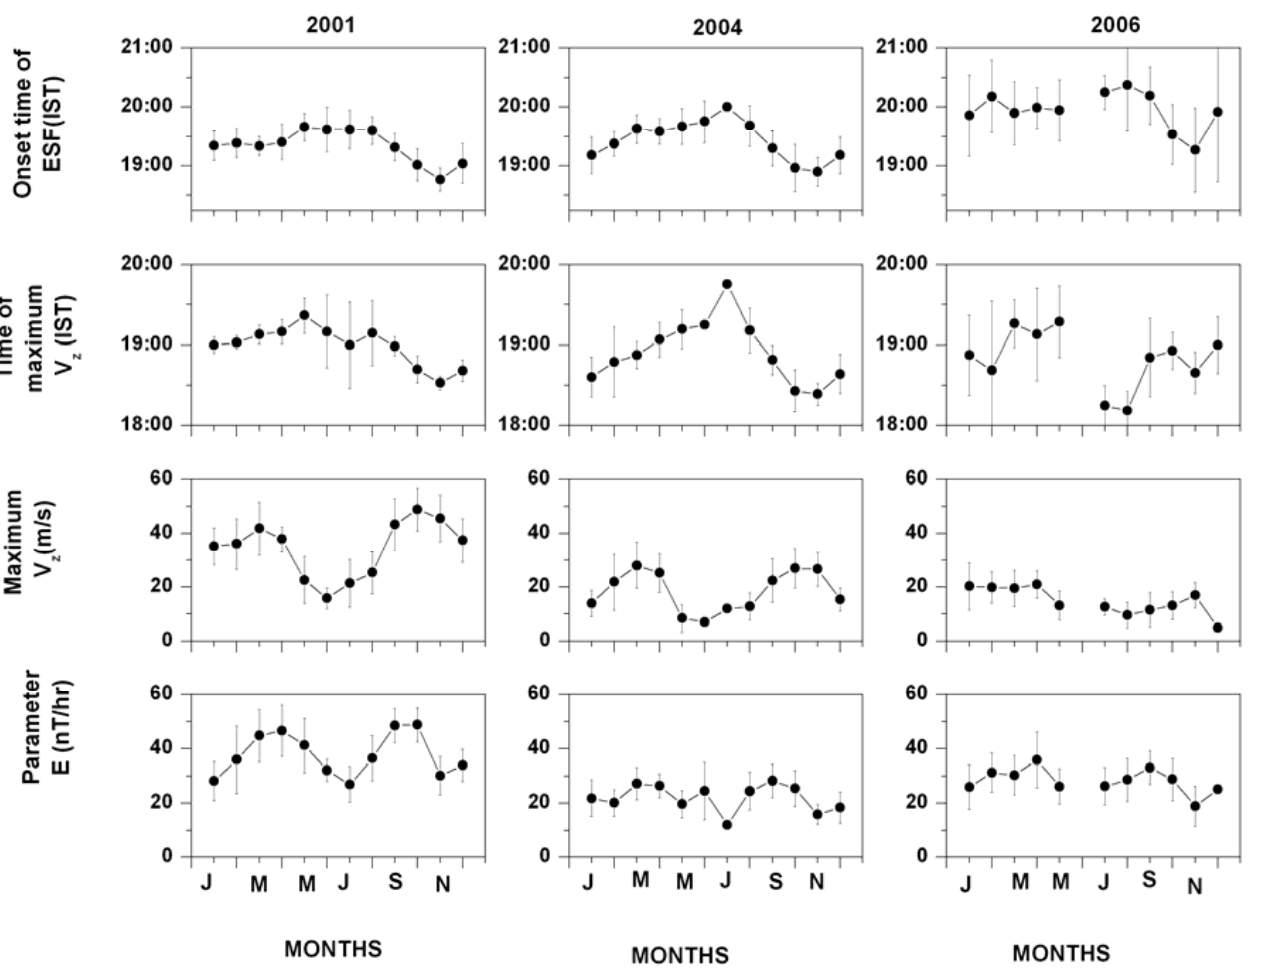
Fig. 5. Monthly mean variations of the “parameter E”, maximum F-region vertical drift velocity ( V z ) , its occurrence time and the onset time of ESF with the corresponding standard deviation for 2001, 2004 and